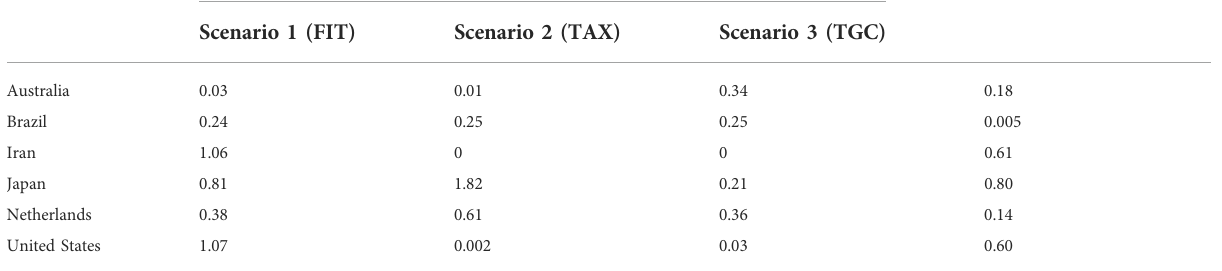
Table 7 re fl ects that the number of members who left an